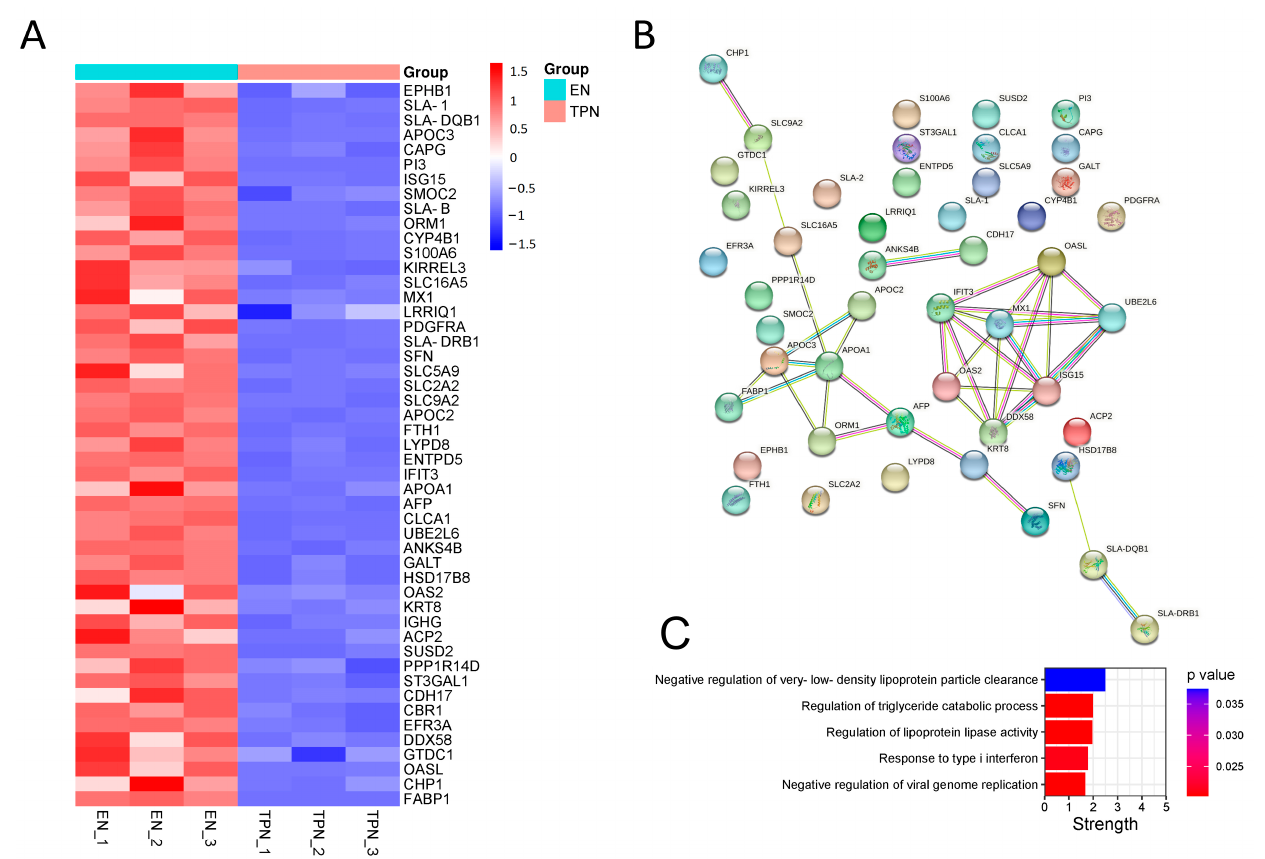
Figure 4. Top 50 down-regulated proteins in TPN piglets. ( A ) Heatmap of top 50 down-regulated proteins in TPN piglets. ( B ) Protein–protein interaction (PPI) analysis among top 50 down-regulated proteins. ( C ) Enrichment strength evaluation of PPI.